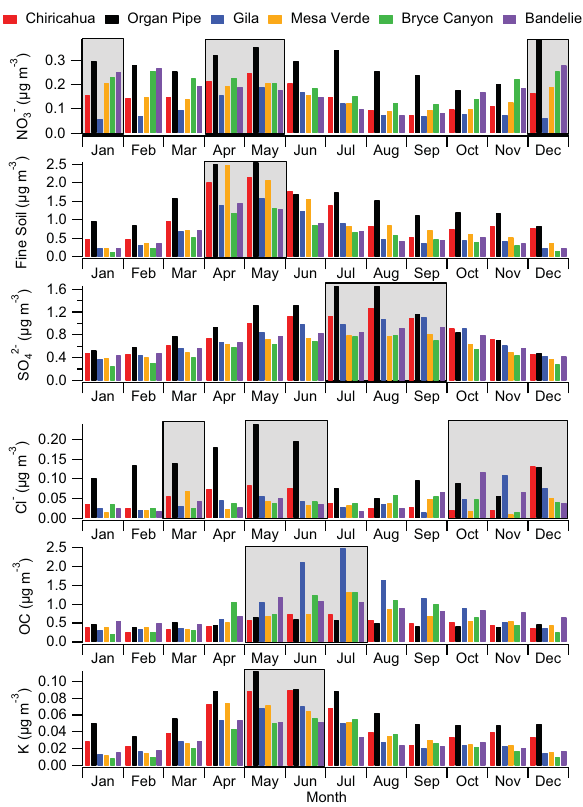
Fig. 6. Average monthly PM 2 . 5 constituent mass concentrations at six EPA IMPROVE sites. Shaded regions represent when maxima are observed for individual or groups of sites. These results are based on data ranges shown in Table 1 for each site.